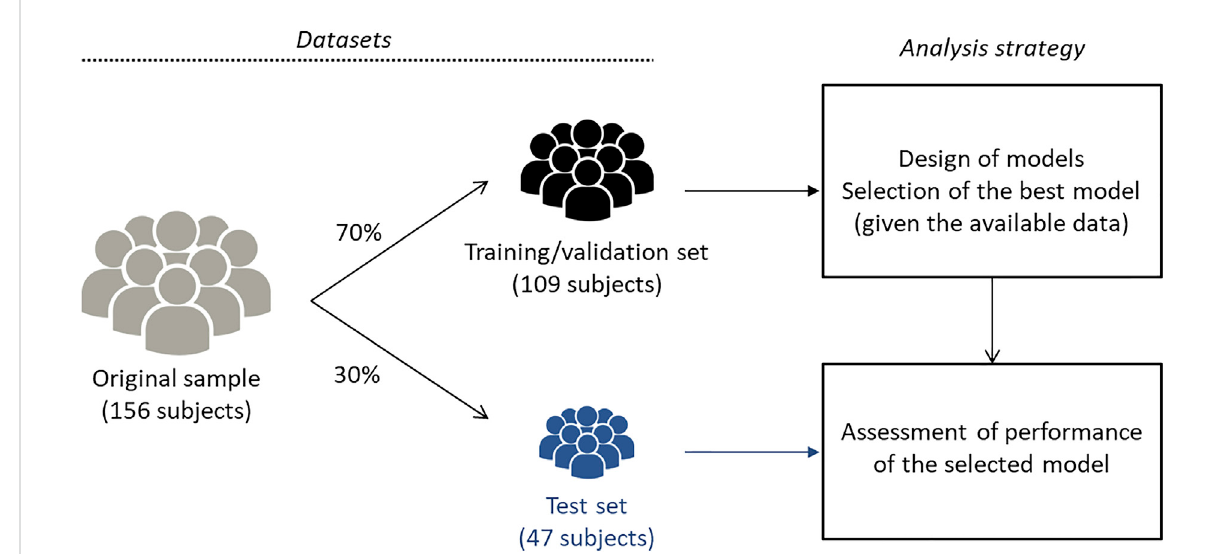
FIGURE 1 Flowchart of datasets and analysis strategy. The original sample included data from 156 participants. Models of different complexities were designed, and the best model (given the available data) was selected by leave-one-out cross-validation with the training/validation set, a subset of the original sample including 70% of the available examples (109 subjects). The performance of the selected models was assessed on the remaining 30% of the available examples (47 subjects). Thus, model training and selection were exclusively based on the training/validation set, while the assessment of the performance of the selected models was performed on a disjoint data